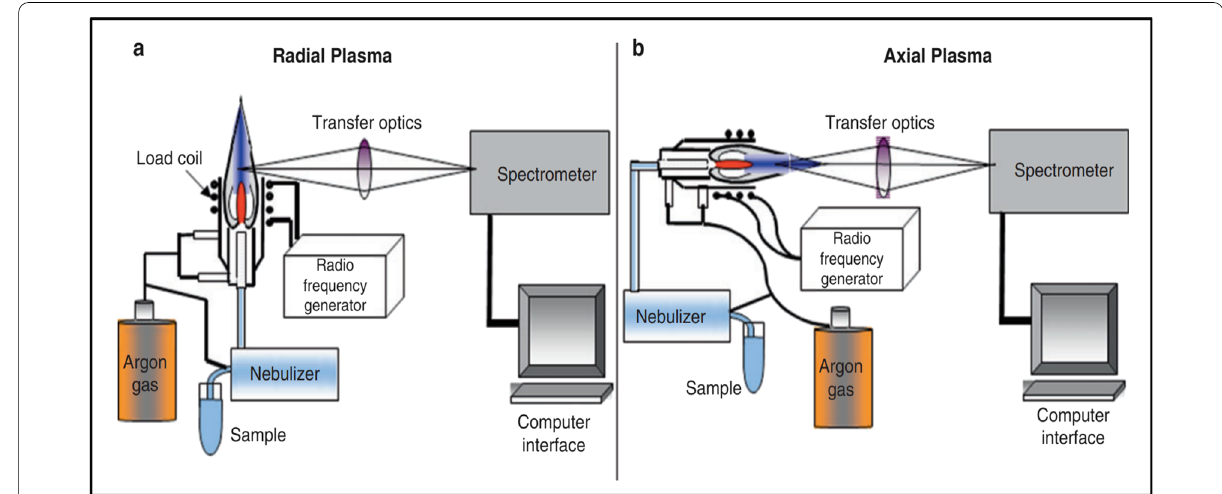
Fig. 3 Components layout of a radial ICP-OES and b axial ICP-OES instrument (Rutzke